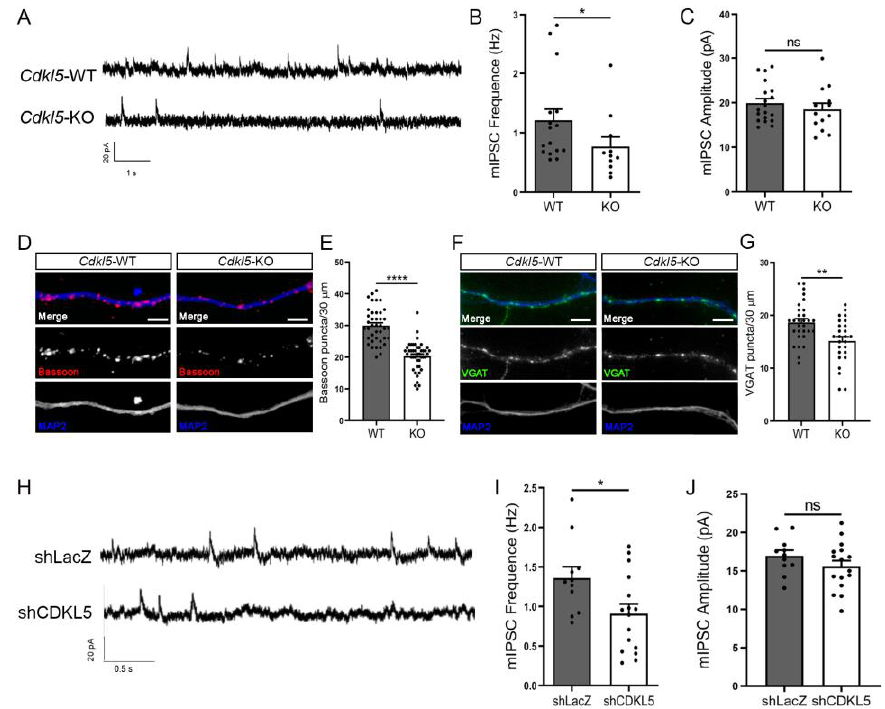
Figure 3. CDKL5 loss leads to a reduction in the frequency of mIPSCs and in presynaptic inhibitory markers. ( A ) Representative traces of mIPSCs recorded from Cdkl5 -WT/KO primary hippocampal neurons at DIV14 patching at +10 mV. ( B , C ) Graphs showing mIPSC frequency ( B ) and amplitude ( C ) in Cdkl5 -WT/KO cultures. n = 3 biological replicates; frequency: N = 16/11 WT/KO neurons. Mean ± SEM * p < 0.05, not significant (ns), p > 0.05. mIPSC frequency: Mann Whitney U test; mIPSC amplitude: Unpaired Student’s t -test. ( D , F ) Representative images of Cdkl5 -WT/KO neurons at DIV14 stained for Bassoon (red, D), VGAT (green, F) and MAP2 (blue). Scale bar, 5 µ m. ( E , G ) Graphs showing the quantification of bassoon and VGAT puncta along 30 µ m long dendritic segments. Bassoon: n = 7 biological replicates, N = 40/44 neurons. VGAT: n = 3 biological replicates, N = 30/26 neurons. Mean ± SEM ** p < 0.01, **** p < 0.0001. Unpaired Student’s t -test. ( H ) Representative traces of mIPSCs recorded from CDKL5-silenced neurons (shCDKL5) and controls (shLacZ). Neurons were transfected with GFP-expressing shRNA vectors at DIV11 and mIPSCs were recorded at DIV14 patching at +10 mV. ( I , J ) Graphs showing mIPSC frequency ( I ) and amplitude ( J ) upon acute CDKL5-silencing. n = 3 biological replicates; N = 11/16 shLacZ/shCDKL5 neurons. Mean ± SEM * p < 0.05; ns, p > 0.05. Unpaired Student’s t -test.